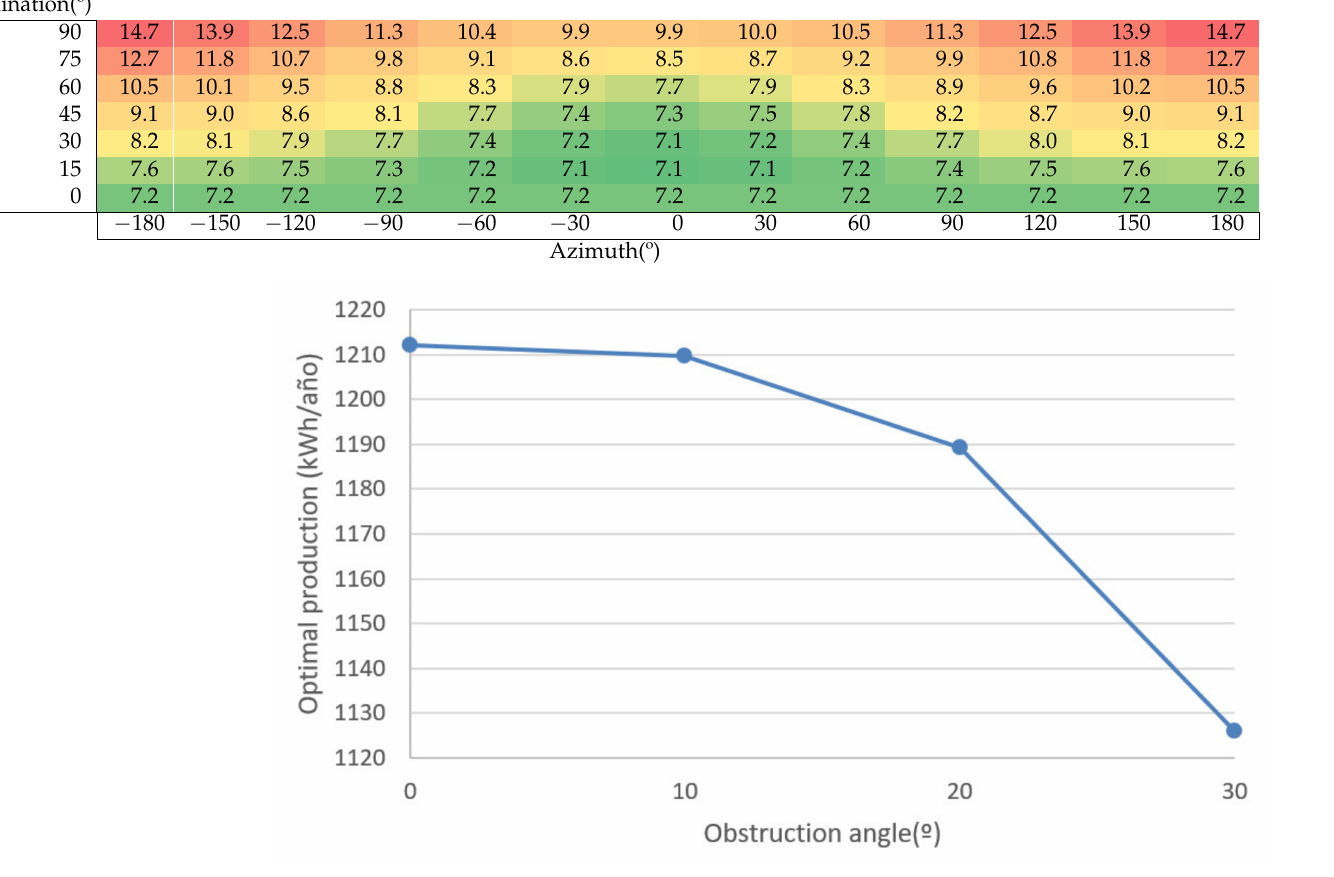
Table 8. Pay − back of a 1000 Wp PV installation and an obstruction angle of 30 ◦ as a function of the azimuth and inclination of collectors.